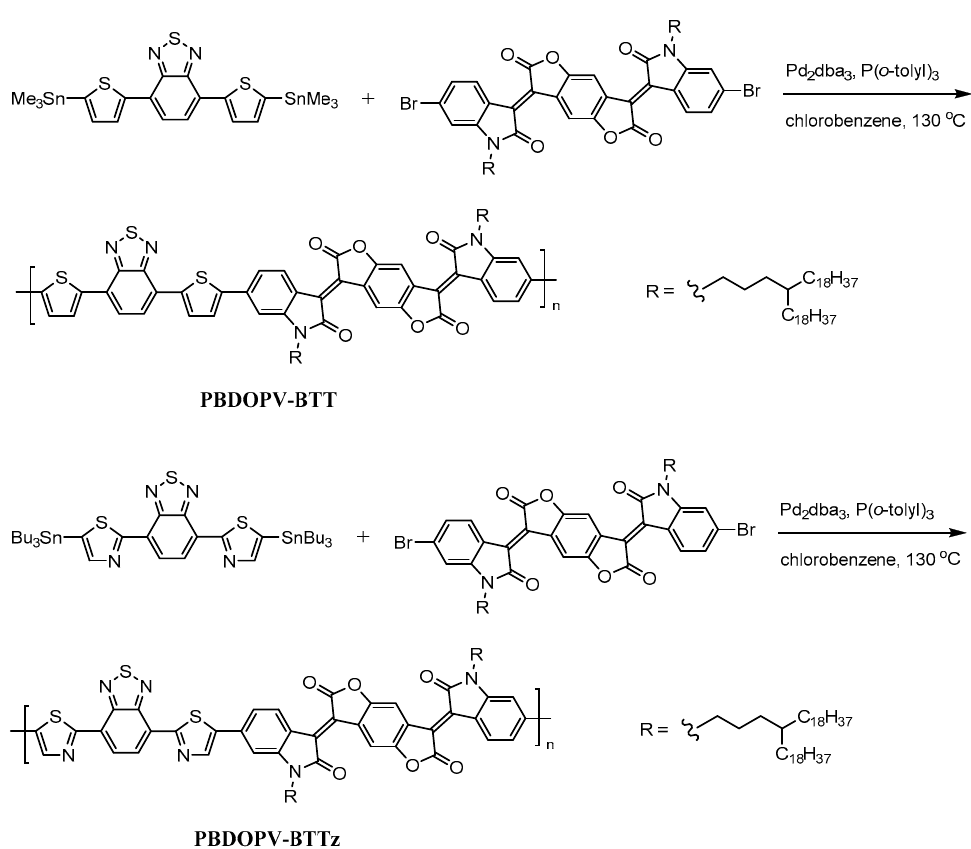
Figure 2. Synthesis of BDOPV-benzothiadiazole-based semiconducting polymers.